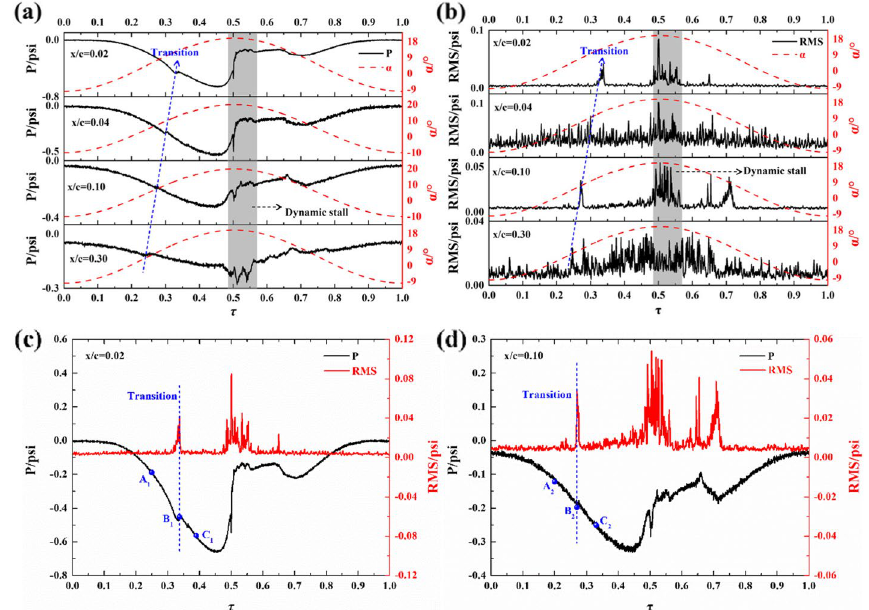
Fig. 2 Fluctuating pressure and RMS at typical positions. a Raw pressure signal, b VSWT RMS value, c pressure characteristics at x / c 0.02, d pressure characteristics at x / c =